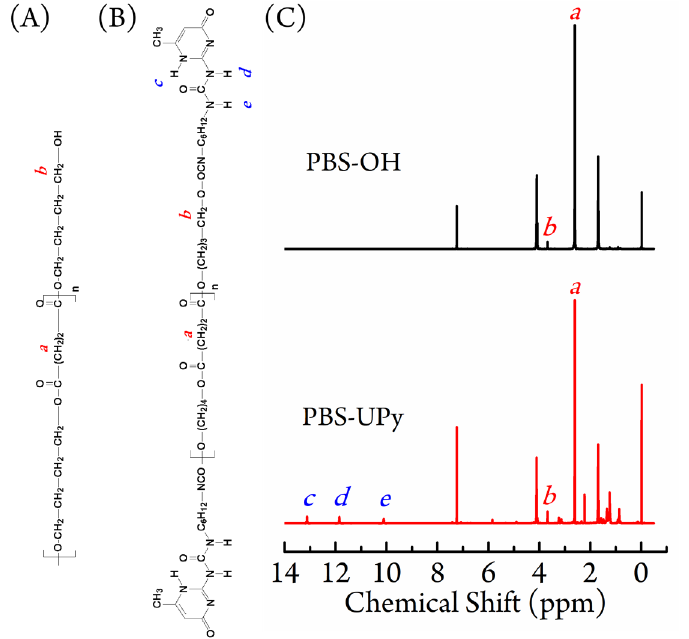
Figure 1. The chain chemical structure of PBS-OH ( A ) and PBS-UPy ( B ), and their representative 1 H NMR spectra ( C ). Table 1. The number-average molecular weights ( M n s) of PBS-OH and PBS-UPy samples. Sample M n (g/mol) Sample M n (g/mol) PBS-OH-1.0k 1.0 × 10